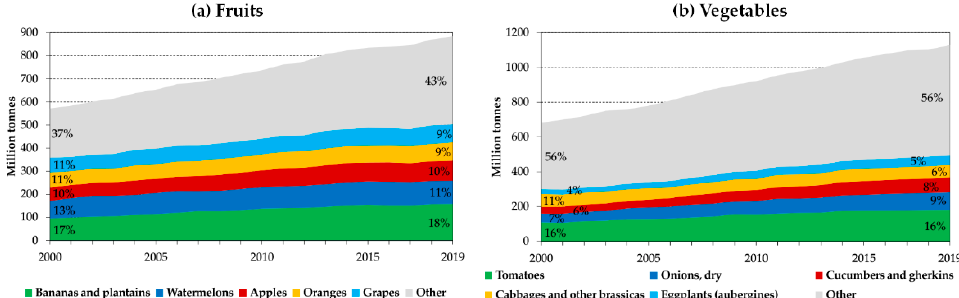
Figure 2. World production of fruits ( a ) and vegetables ( b ), main commodities (adapted from [7]). Compared to fruit production, the world vegetable production grew faster between 2000 and 2019 to 1128 million tonnes in 2019, corresponding to an increase of 65%. The five main vegetable species, tomatoes (16% in 2019), onions (9%), cucumbers and gherkins (8%), cabbages (6%), and eggplants (5%), accounted for 44% of the total production in 2019 (Figure 2b). The share of cucumbers and gherkins, onions, and eggplants increased, while that of tomatoes remained stable and that of cabbages almost halved (Figure